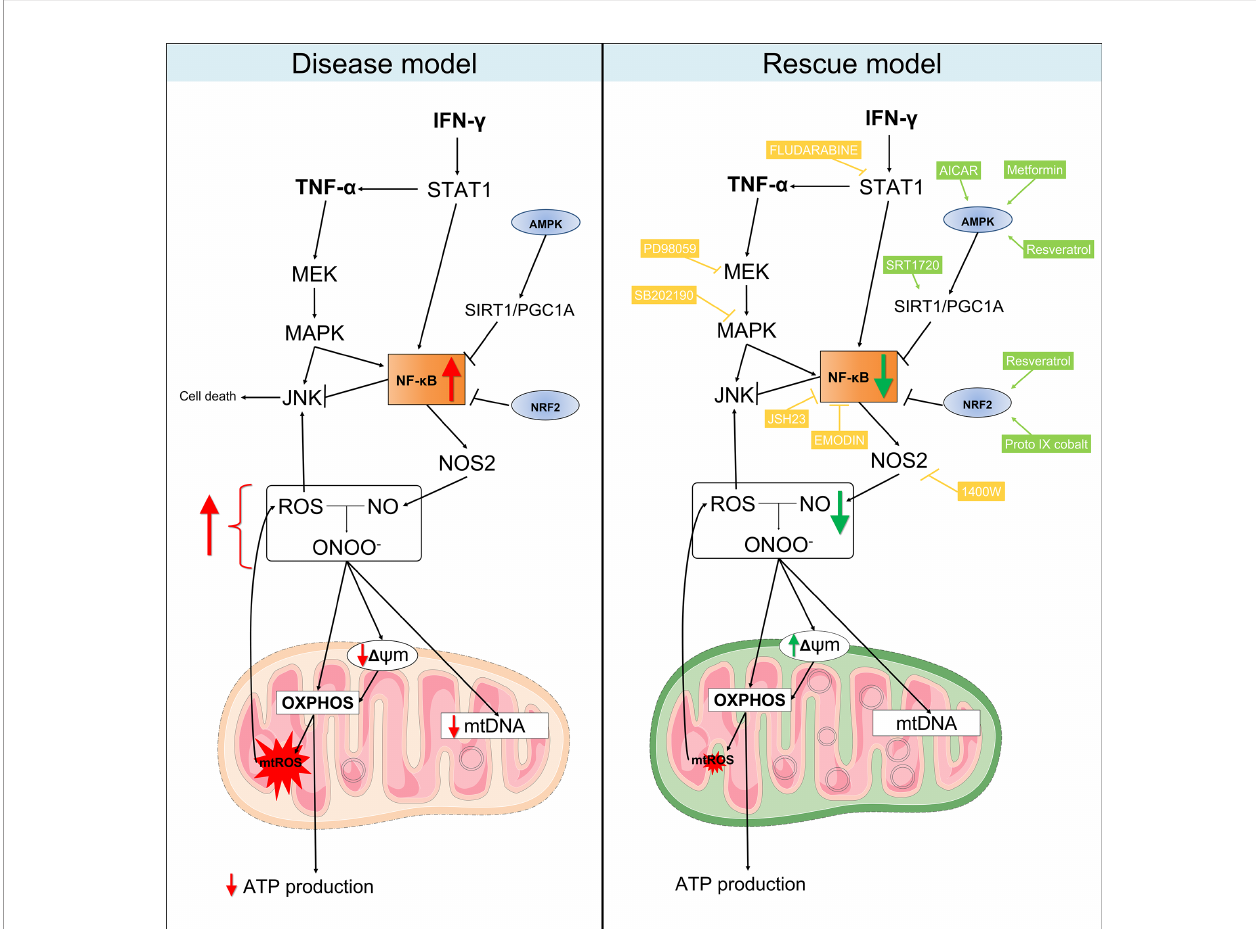
FIGURE 8 | Proposed model for the mitochondrial dysfunction in Chagas disease cardiomyopathy. Left panel: in summary, our results showed that heart tissues from CCC patients have increased production of RNS and reduced content of mitochondrial DNA in comparison with patients with DCM. Similarly, stimulation of AC-16 cardiomyocytes with IFN- g /TNF- a increased ROS, RNS and proton leak, impaired DY m, depleted ATP production and changed the metabolic pro fi le of the cells. Right panel: in our rescue model, we showed that pharmacological inhibition of molecules involved in the IFN- g /TNF- a /NF- k B/NOS2 pathway ameliorated the DY m and NO production. Additionally, activation of AMPK/SIRT1 and NRF2 had bene fi cial impact on the DY m. Thus, we hypothesize that mitochondrial dysfunction is driven by the excessive production of IFN- g /TNF- a in CCC myocardium and is an essential component for the poor prognosis of Chagas disease cardiomyopathy. Mitochondria- targeted therapies might improve CCC disease progression. Compounds in yellow are inhibitors; Compounds in light green are agonists. Connecting arrows indicate activation and fl at line means inhibitory interaction. Red and green arrows indicate the changes observed before and after treatment with the